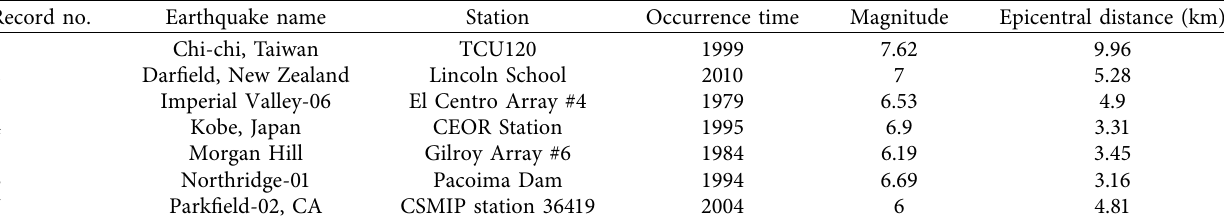
Table 6: Near-field earthquakes characteristics.